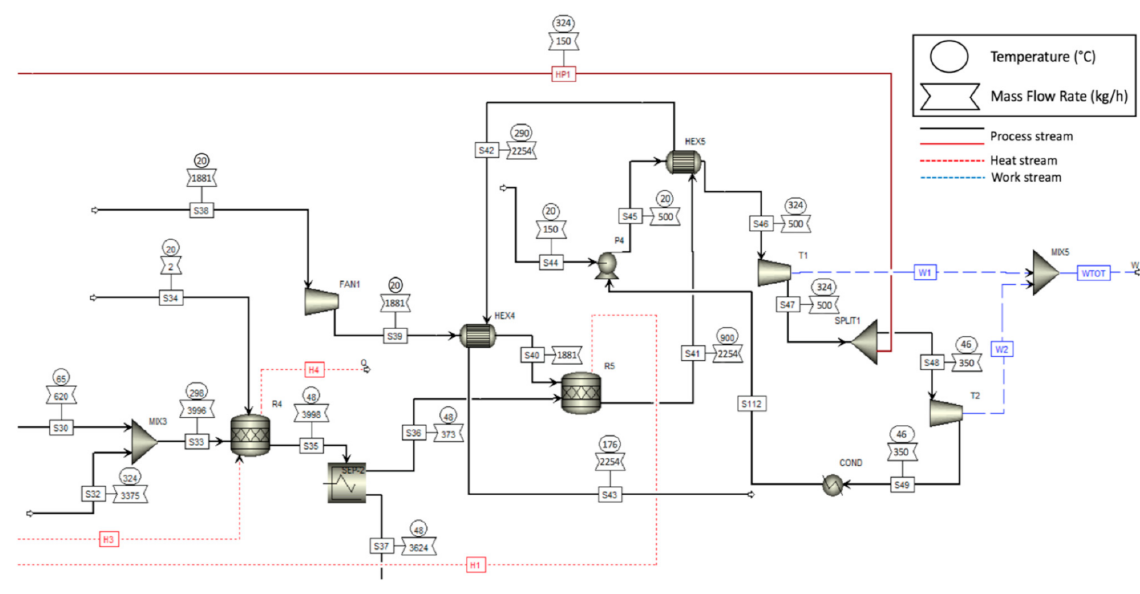
Figure 2. Flowsheet of enzymatic hydrolysis and combustion section as simulated using Aspen Plus.